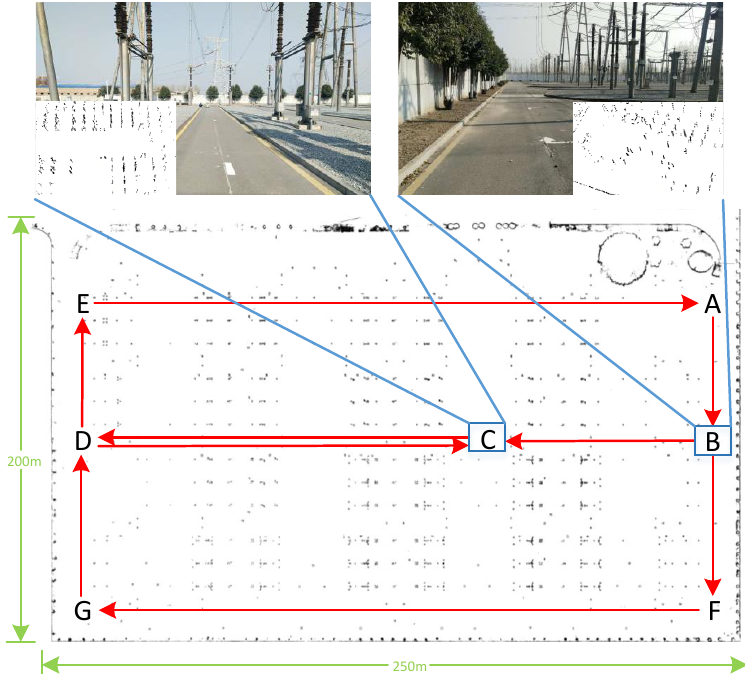
Figure 8. The plan and the environment of substation B.